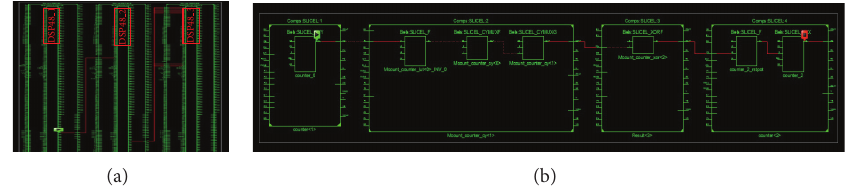
Figure 9: (a) Critical path in Vivado implementation. (b) Critical path in proposed